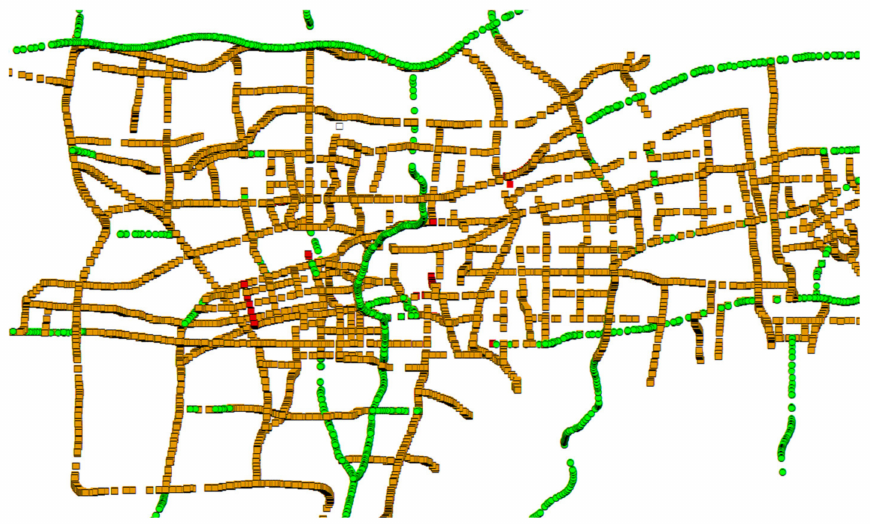
Figure 7. Schematic diagram of road conditions during the weekend. (The closer the road color is to green, the smoother the road. The closer the road color is to red, the more congested it